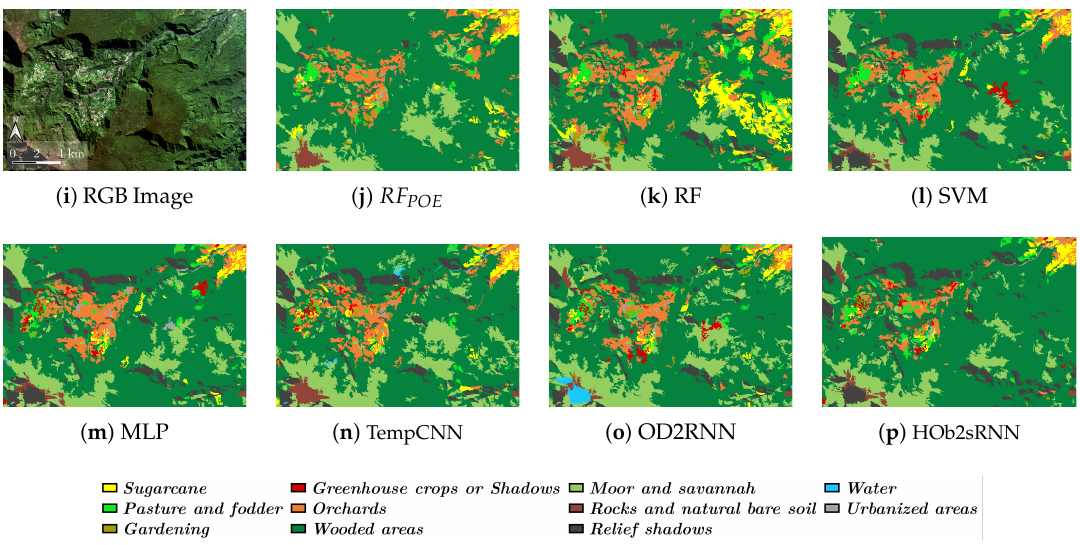
Figure 14. Qualitative investigation of land cover map details produced on the Reunion island study site over a mixed urban/agricultural area (top) and an agricultural/natural vegetation area (bottom).